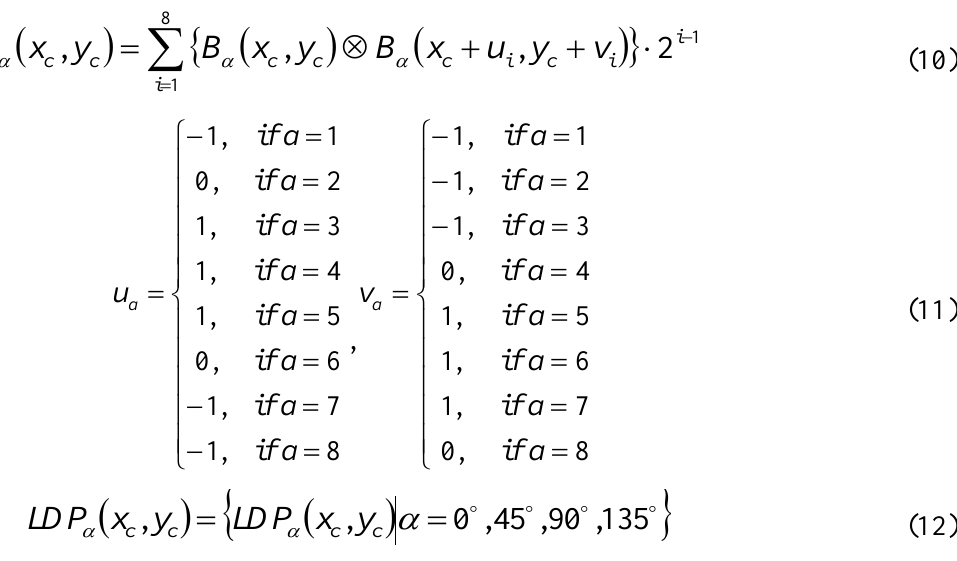
Figure 8. Eight adjacent pixels around I